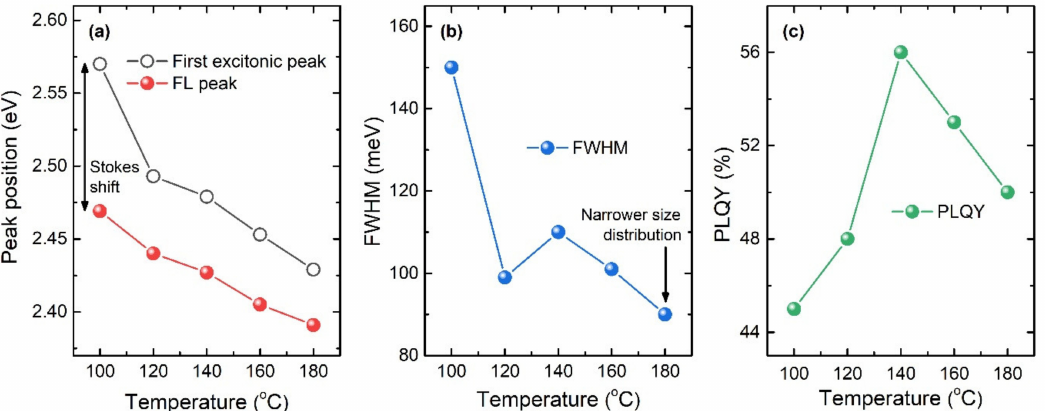
Figure 2. Optical analysis of CsPbBr 3 perovskite NCs as a function of reaction temperature: ( a ) Fluorescence and first exci- tonic absorption peak positions; ( b ) full-width at half-maximums (FWHMs); ( c ) photoluminescence quantum yield (PLQYs).